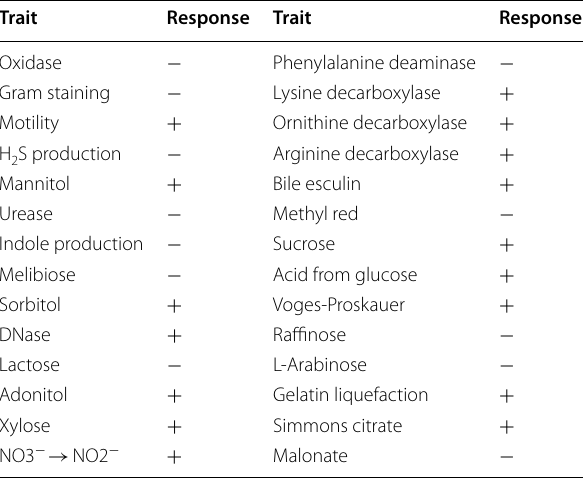
Table 1 Physiological and biochemical characteristics of